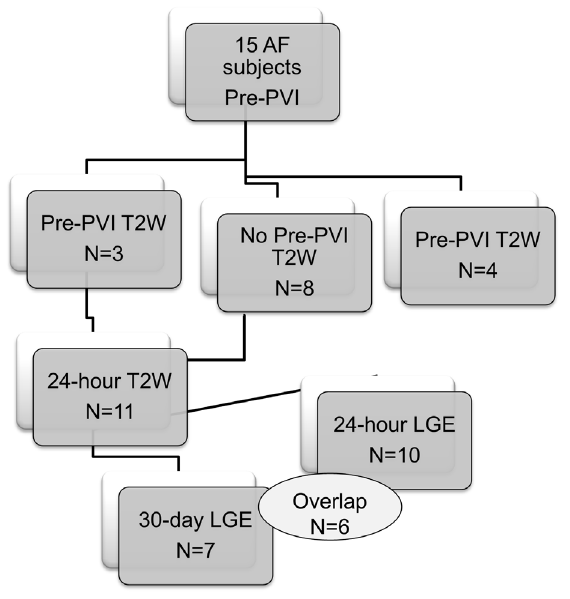
Figure 1. Flow chart describing the number of patients with T2W and LGE images at each time-point for the entire cohort. T2W=T2-weighted imaging. LGE=Late gadolinium enhancement. PVI=pulmonary vein isolation. Data from all available studies